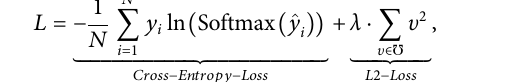
Frontiers in Communications and Networks |